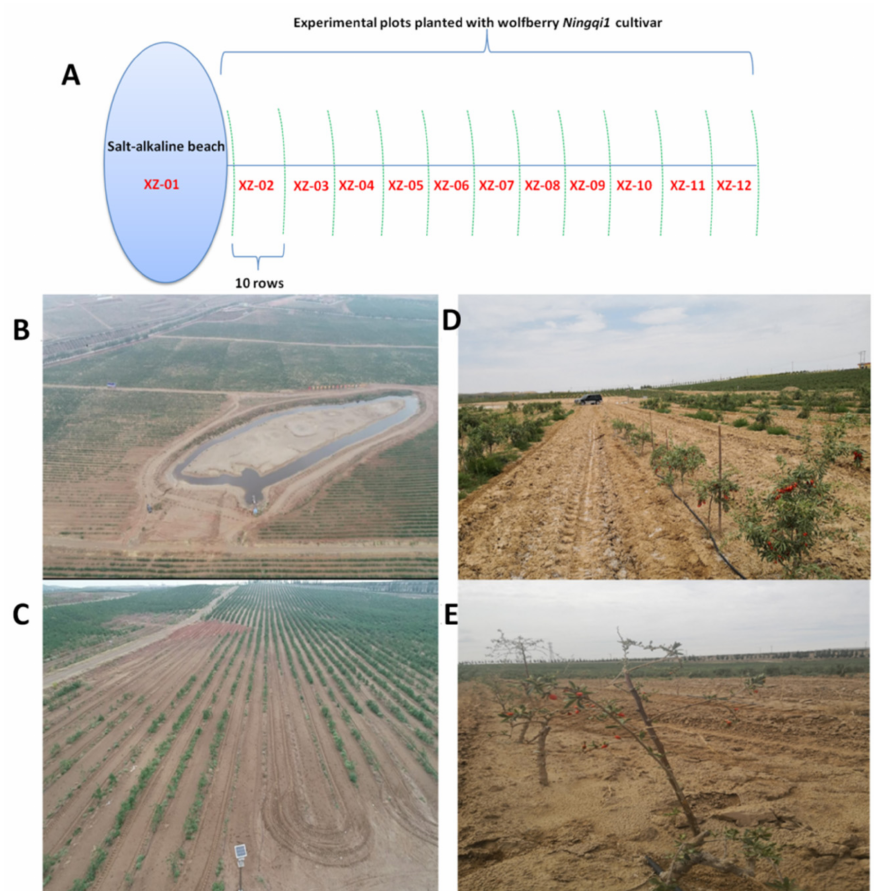
Figure 1. Field layout and experimental condition of the study area. ( A ) Experimental set up. Twelve salt-alkaline gradients were collected, numbered sequentially from XZ-01 to XZ-12. Each gradient consists of 10 rows of Ningqi1 trees; ( B ) Positions of the salt-alkaline beach in the field; ( C ) Definition of the stress gradients based on 10 parallel rows of wolfberry Ningqi1 trees away from the beach; ( D , E ) Wolfberry Ningqi1 trees under severe salt-alkaline